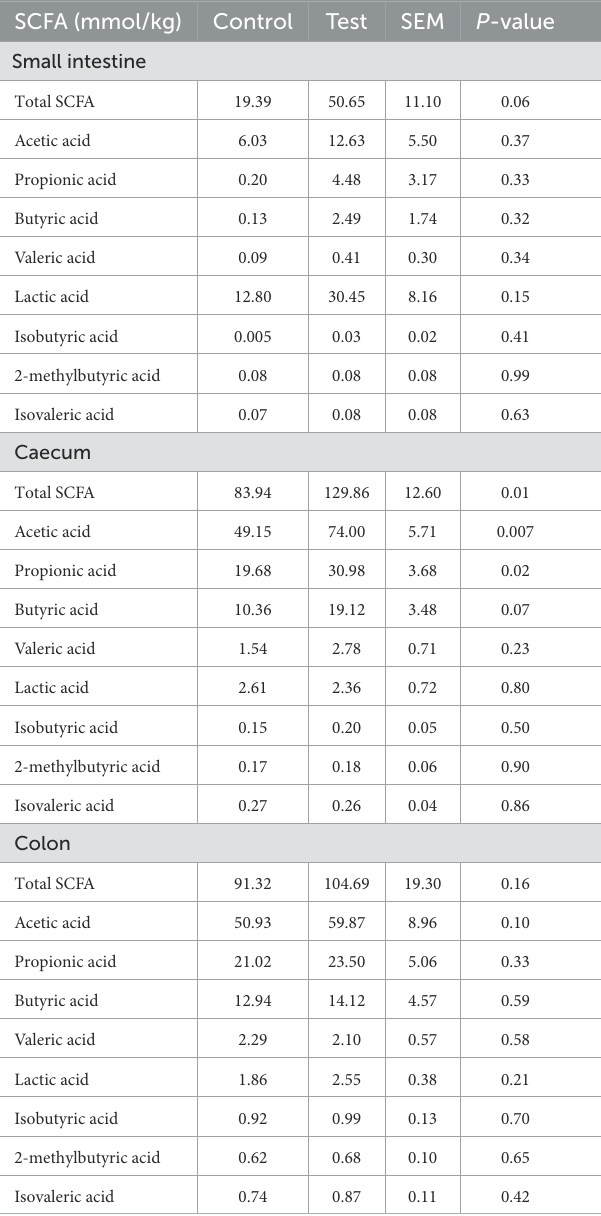
TABLE 9 Biomarkers of intestinal inflammation in the feces of piglets at d14 post-weaning, when fed a control diet (Control; n = 10) or a